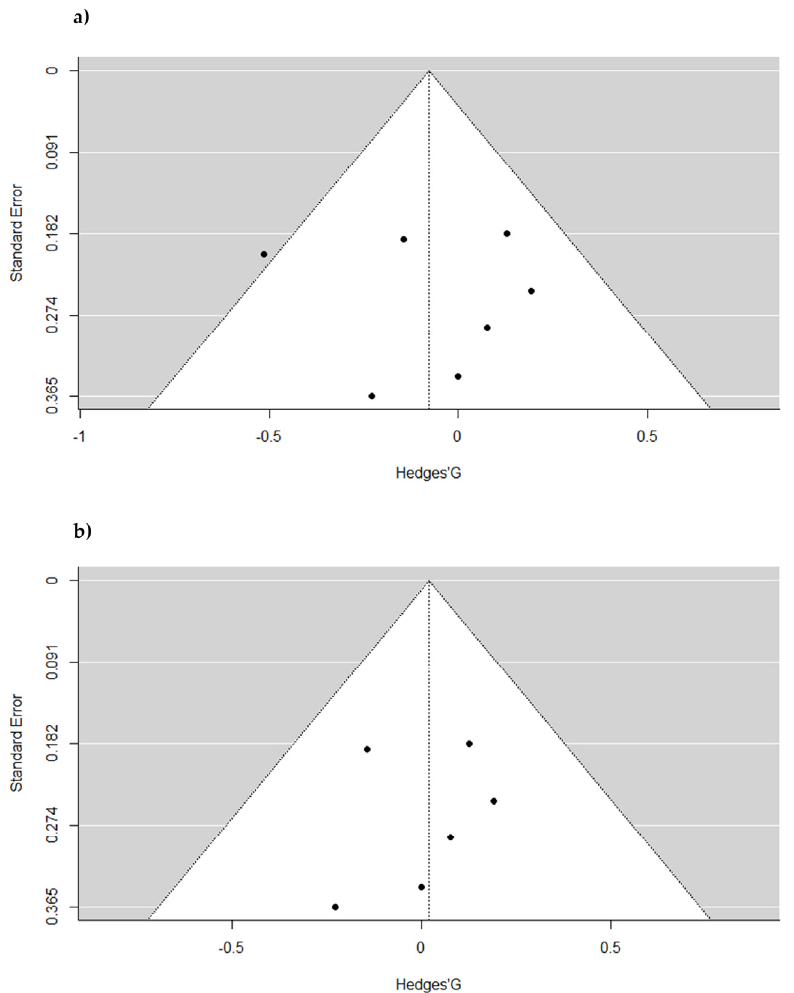
Figure 3. Funnel plots of included studies considering High-density lipoproteins. Funnel plot (standard error vs. Hedges’ G). ( a ) represent all of the studies included in this SRMA. ( b ) represent the results after excluding one study not evenly distributed around the base of the funnel plot. After the exclusion of one study, there were no risks of heterogeneity (I 2 = 0%; p = 0.84). The results of the pooled meta-analysis showed significant change on total cholesterol levels after HRW supplementation in clinical population ( p ≤ 0.01), with a small negative effect (pooled SMD = − 0.23 (from − 0.40 to 0.05)). Regarding the triglycerides levels, the result showed significant decrease after HRW supplementation ( p ≤ 0.01), with a moderate negative effect (pooled SMD = − 0.38 (from − 0.59 to 0.18)). Considering LDL, HRW supplementation lowers LDL levels ( p = 0.02) with small effect (pooled SMD = − 0.22 (from − 0.39 to 0.04)). Forest plots are shown in Figure 4.